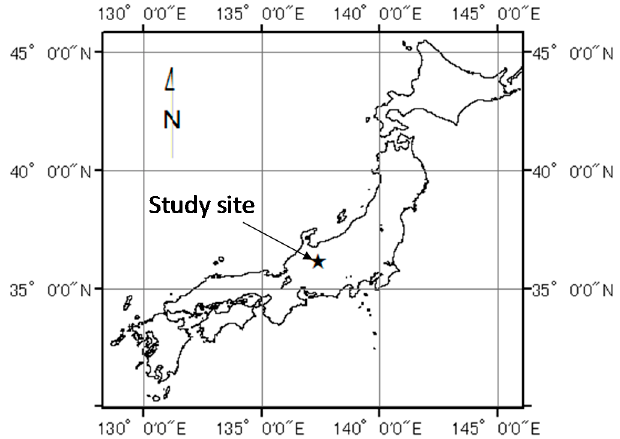
Figure 1. Location of the study site.